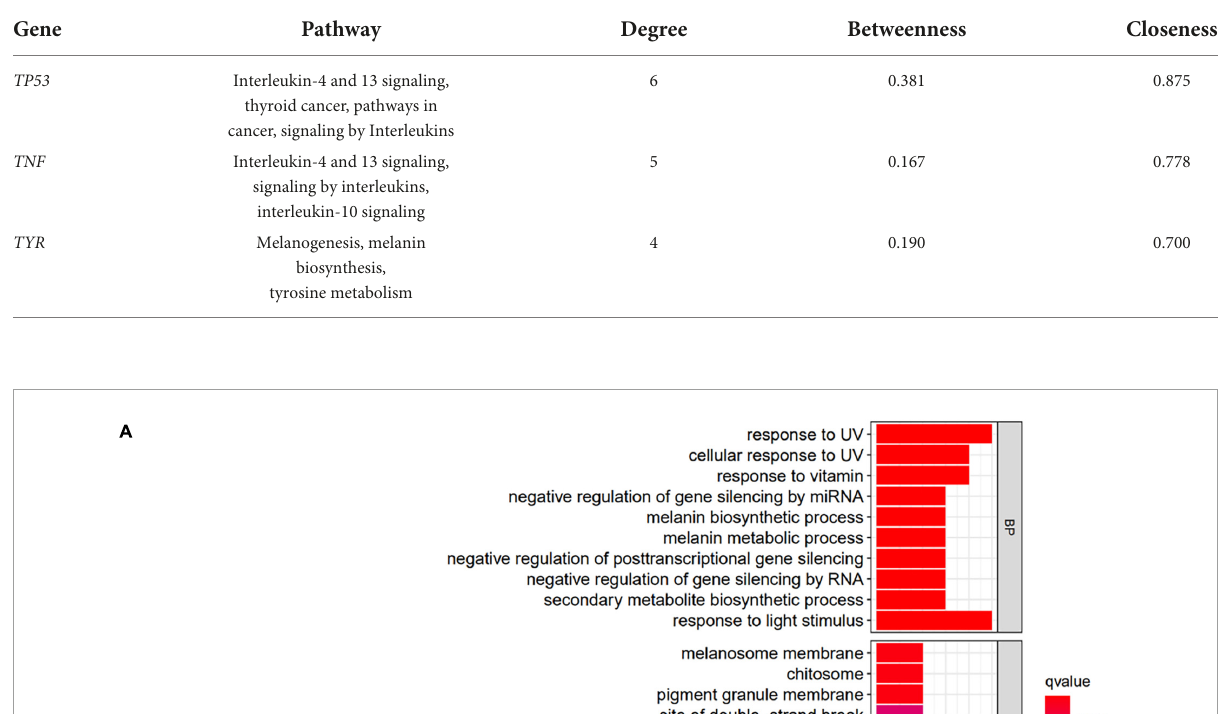
TABLE 5 Basic information of crucial gene in the control of melanoma by vine tea.